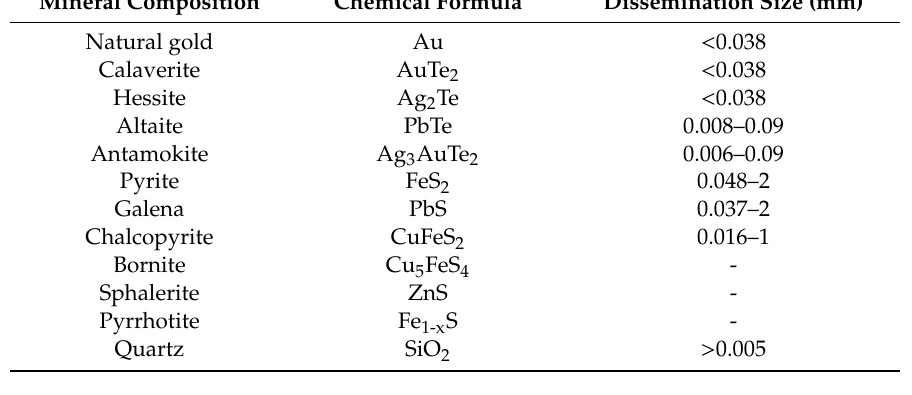
Table 2. Percentage concentrations of multi-element minerals.